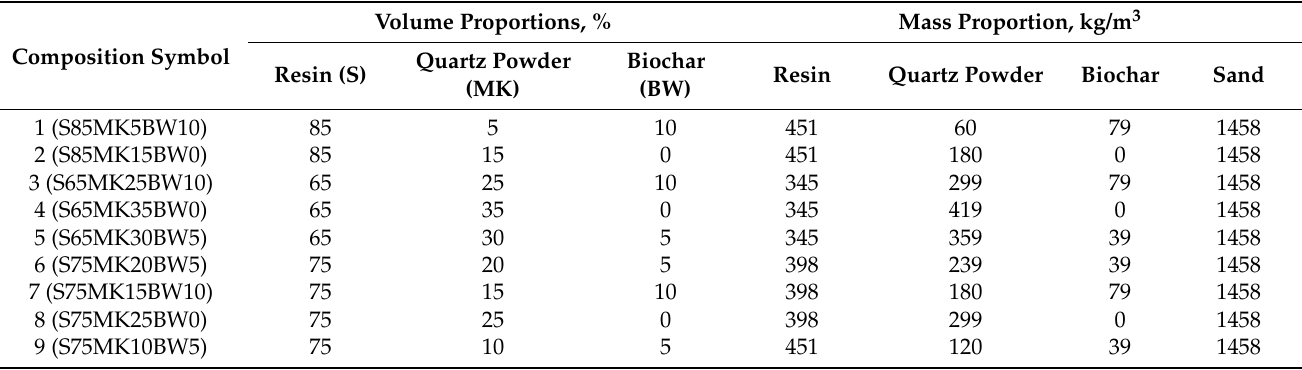
Figure 4. Experimental plan with limitations (orange lines): S—resin, BW—biochar, MK—quartz powder. Table 2. Compositions of analyzed mortars according to the experimental plan.